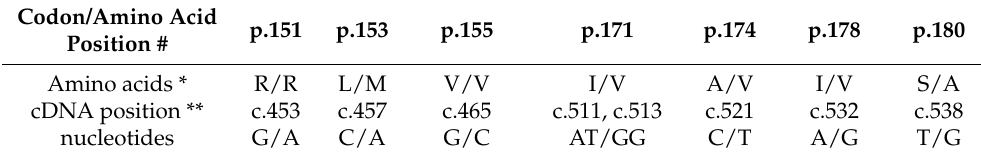
Table 1. SNPs in OPN1LW and OPN1MW exon 3. Codon/Amino